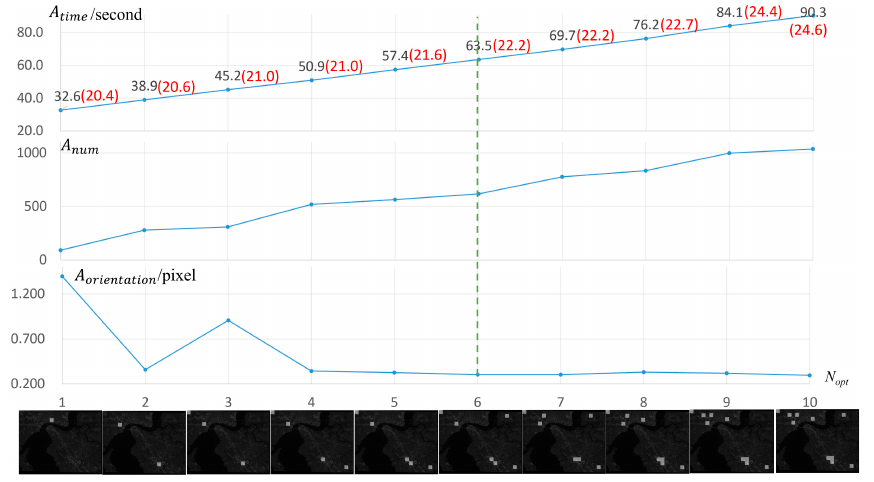
Figure 6. Analysis of 𝑁 (cid:3042)(cid:3043)(cid:3047)